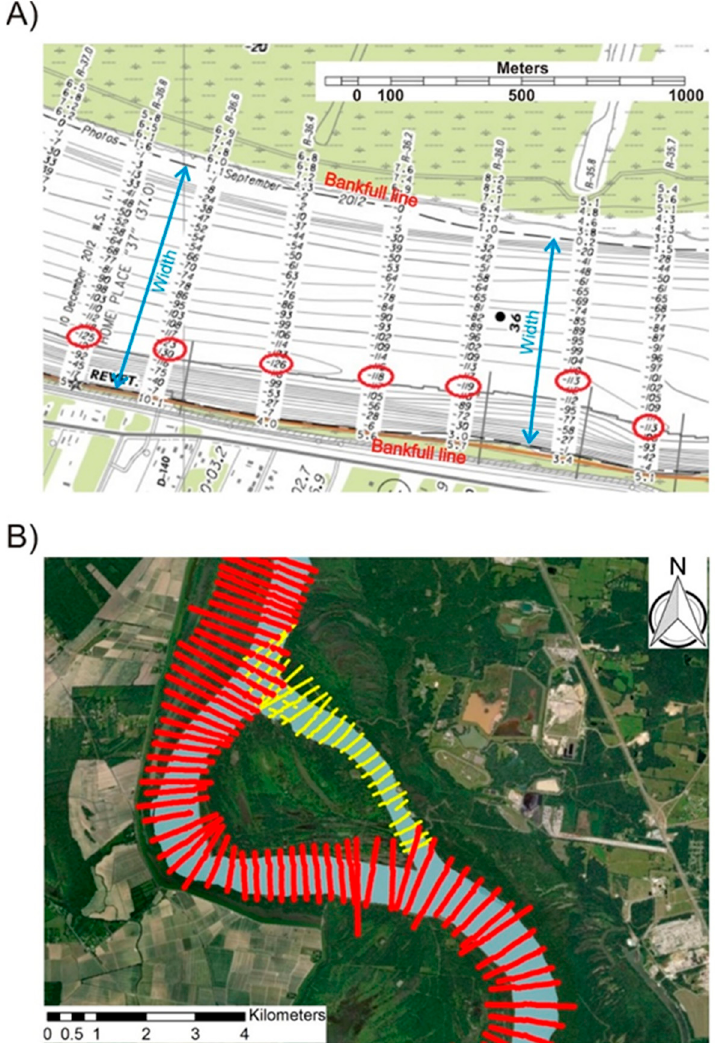
Figure 4. ( A ) The diagram from the hydrographic survey in 2013 shows the schematics of how the channel width (blue lines with arrows) and thalweg points (red circles) are determined. The bankfull or water surface lines are marked by the United States Army Corps of Engineers (USACE), and the channel width is defined by the distance between two bankfull lines. ( B ) The map shows a sand bar dividing the cross-sectional survey in 2013. Those cross-sections in red were located in the main channel and, therefore, were kept in our study, whereas the cross-section in yellow was deleted from our study. See the location in Figure 1.